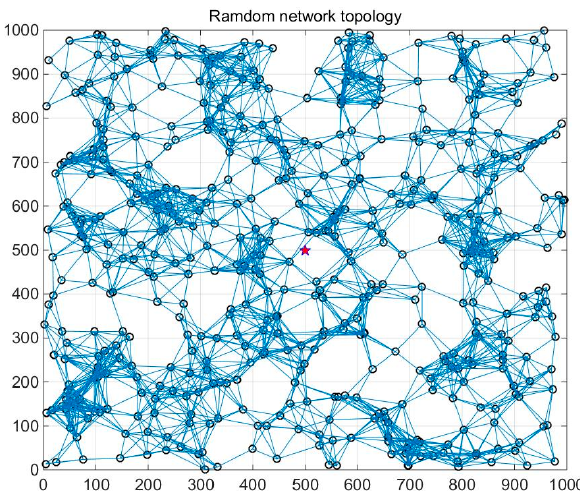
Figure 2. The random topology of synthetized data with 500 nodes in a 1000 m × 1000 m area.